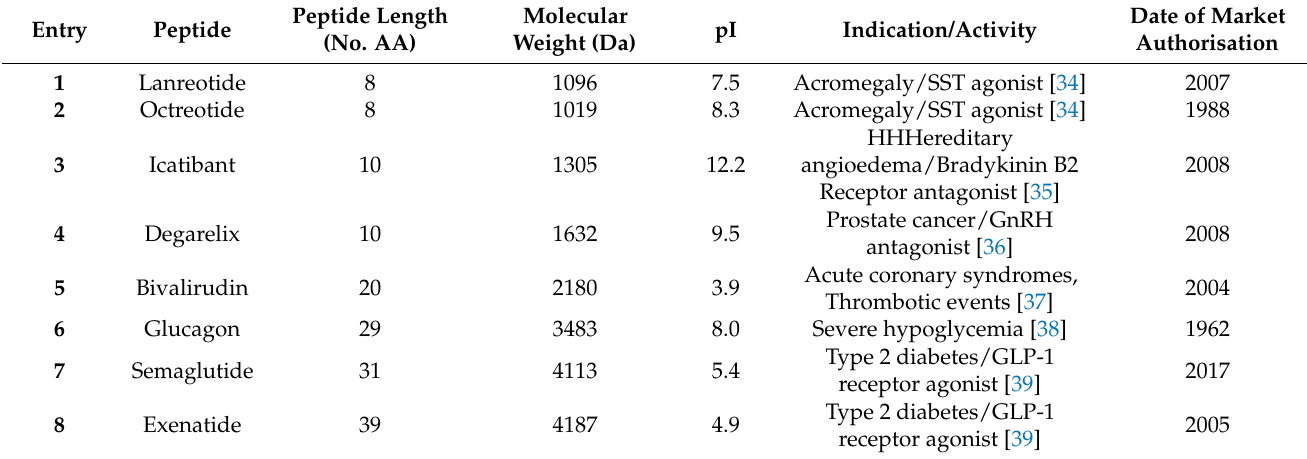
Table 1. List of therapeutic peptides analysed. The peptides were sorted according to the length of the amino acid chain. Peptide Entry Peptide